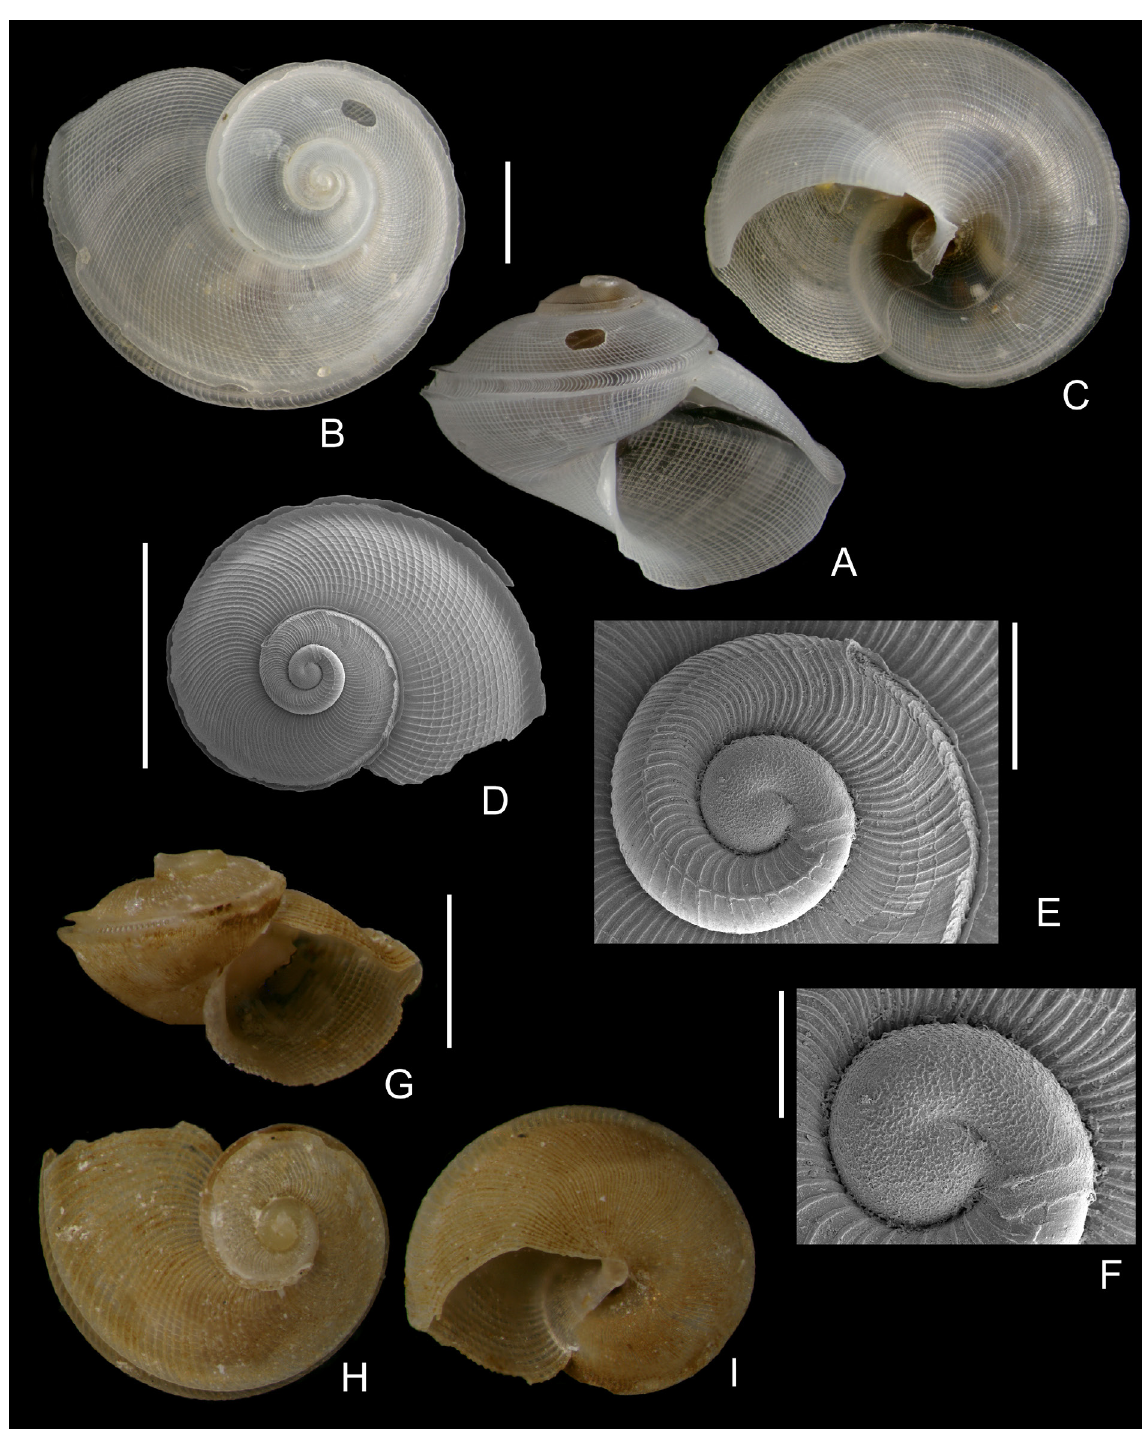
Fig. 7. Anatomidae 1. A–C . Anatoma richardi (Dautzenberg & H. Fischer, 1896), SEAMOUNT 1, DW116, 985–1000 m, diameter 4.2 mm. D–F . A. richardi , shell and detail of the protoconch and early teleoconch whorls, SEM micrograph, same locality, diameter 1.7 mm. G–I . A. cf. richardi , BANGAL 0711, GOC6, 903 m, diameter 2.3 mm. Scale bars: A–D, G–I = 1 mm; E = 200 µm; F = 100